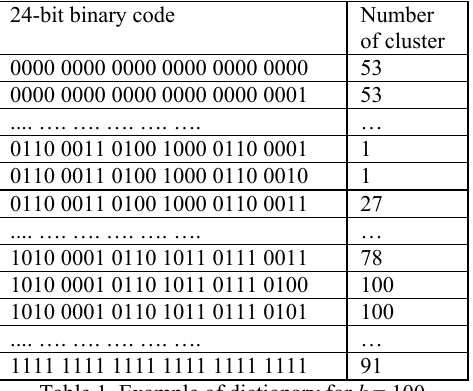
Table 1. Example of dictionary for k = 100